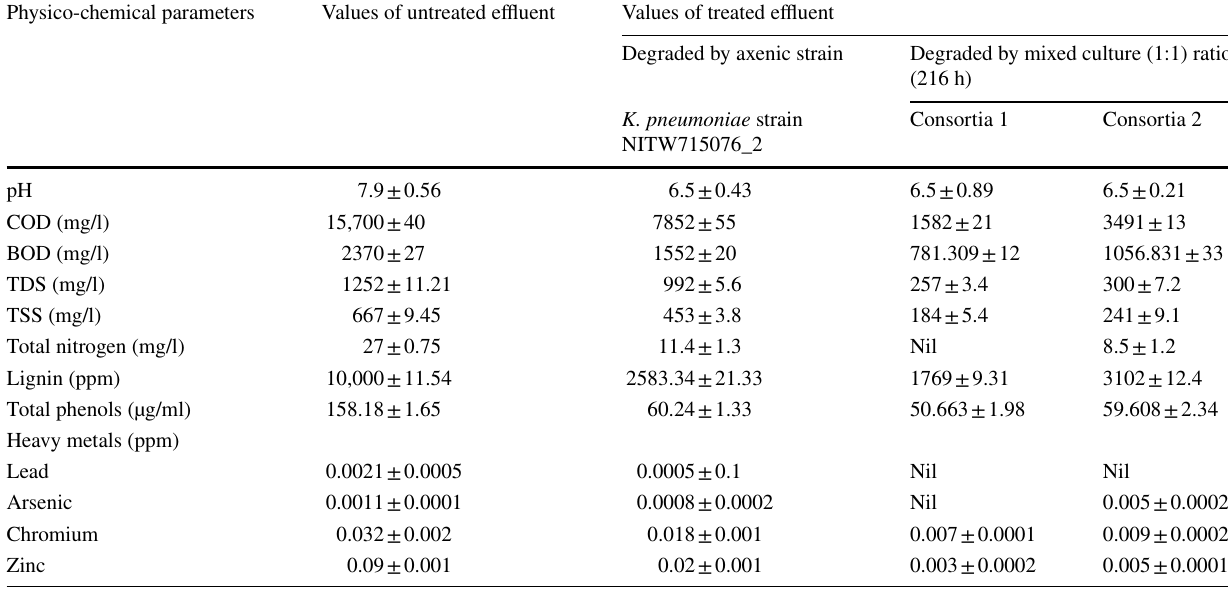
Table 3 Various physico-chemical parameters of effluent sample before and after bacterial treatment Physico-chemical